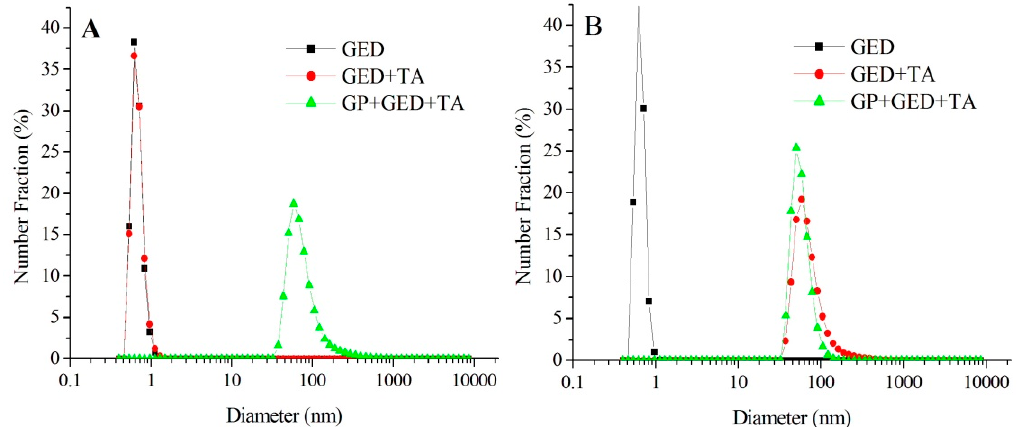
Figure 2. Size distribution curves, from zeta potential measurements, of particles in 8 mol L − 1 urea solutions ( A ) or in water ( B ).